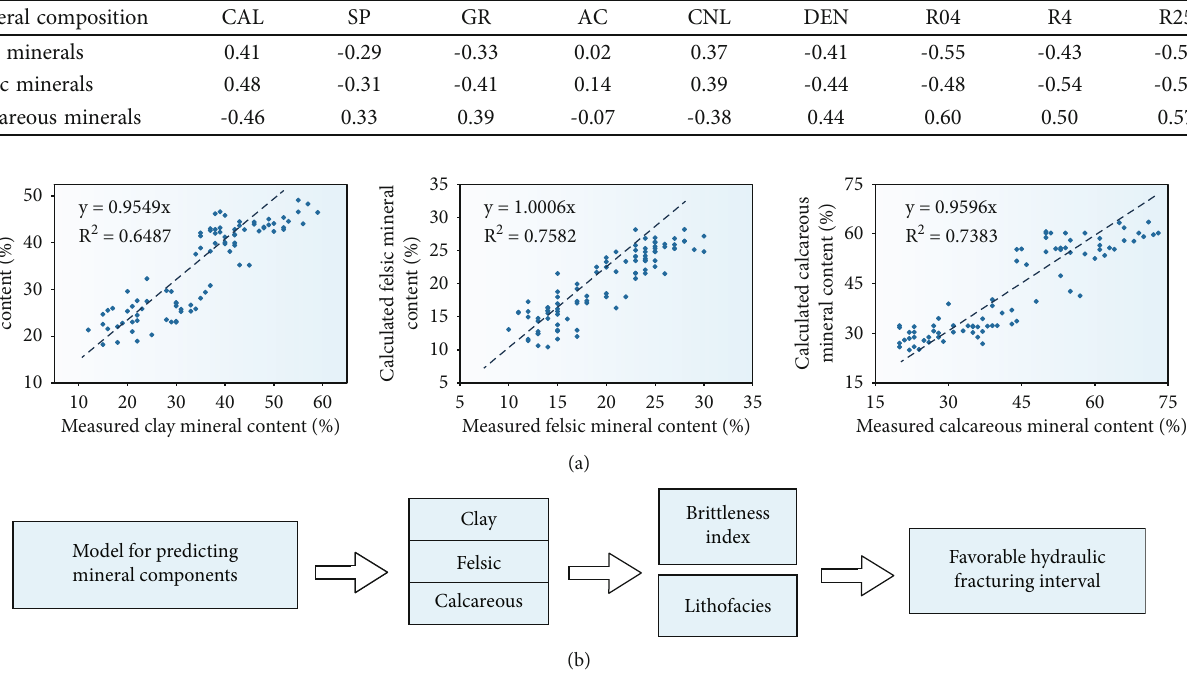
Figure 12: Establishment and application process of the mineral prediction model.